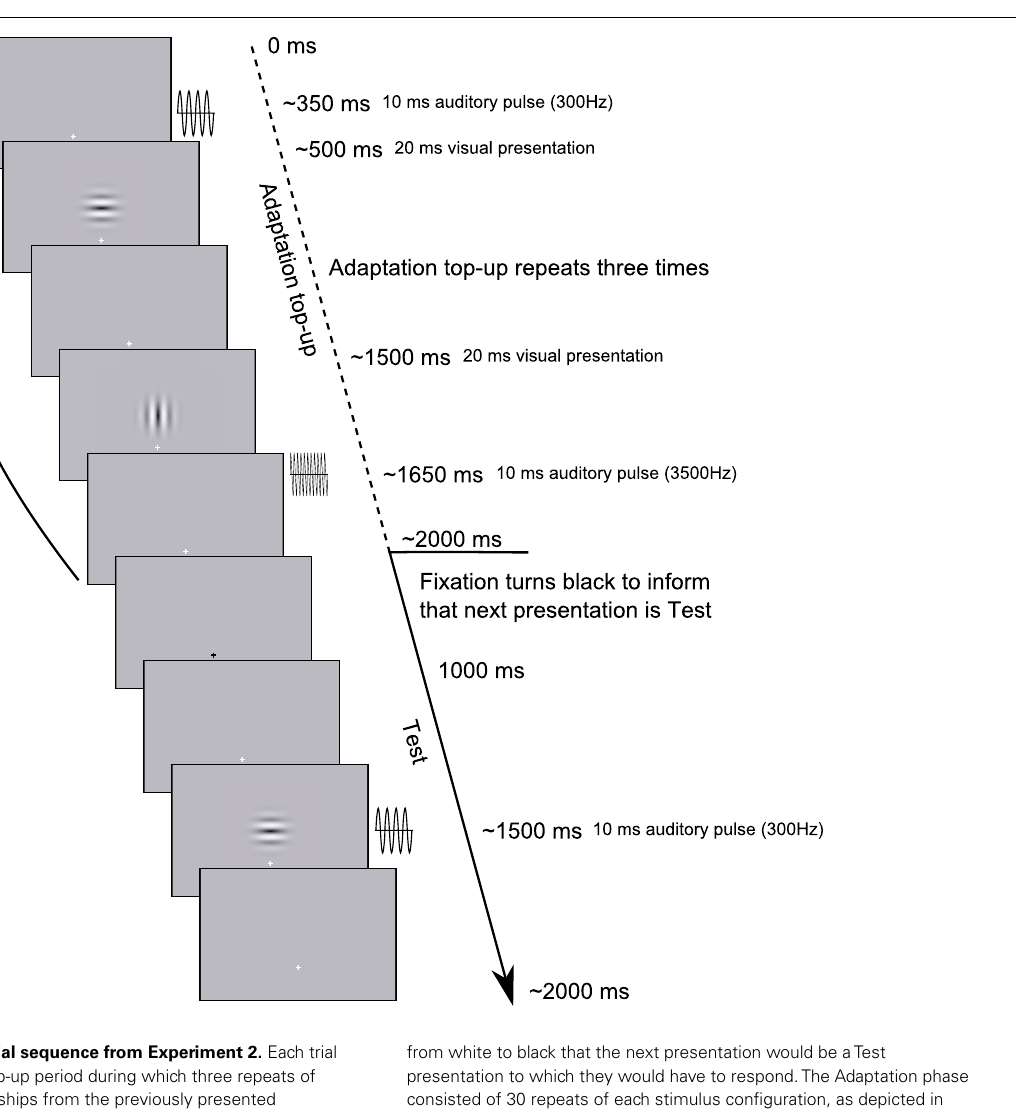
from white to black that the next presentation would be aTest presentation to which they would have to respond.The Adaptation phase consisted of 30 repeats of each stimulus configuration, as depicted in the Adaptation top-up period, before proceeding onto the Adaptation top-up/Test presentation